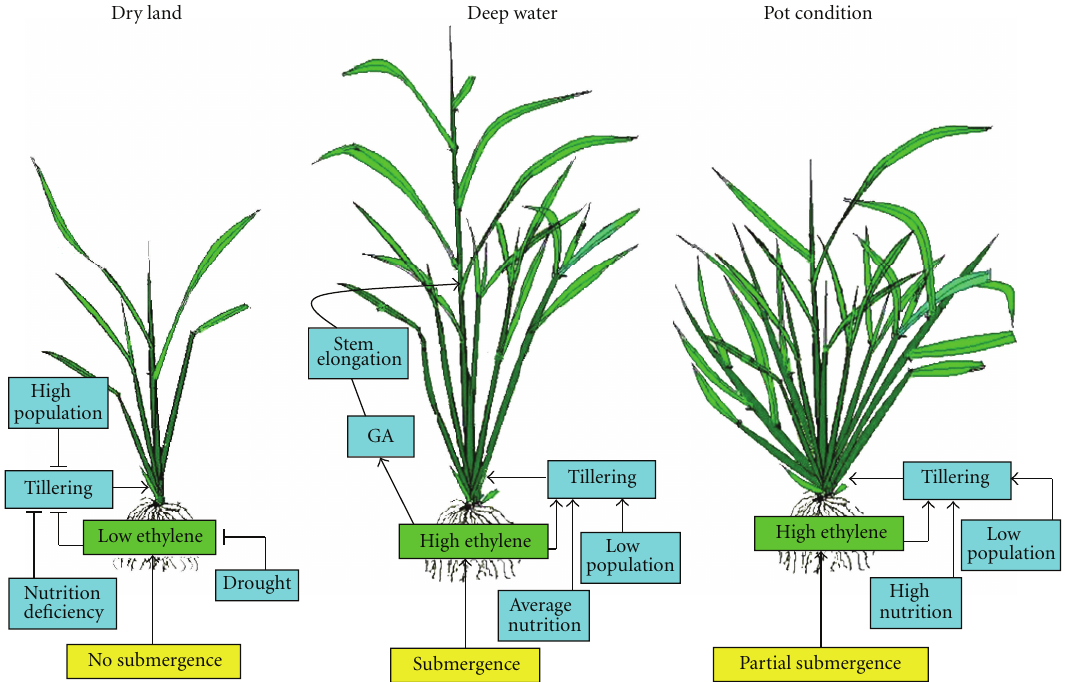
Figure 3: Schematic of the factors controlling tiller dynamics of Oryza rufipogon Gri ff . growing in dryland (natural) and deep water (natural) conditions and cemented pots (manipulated) in the campus of Sambalpur University,